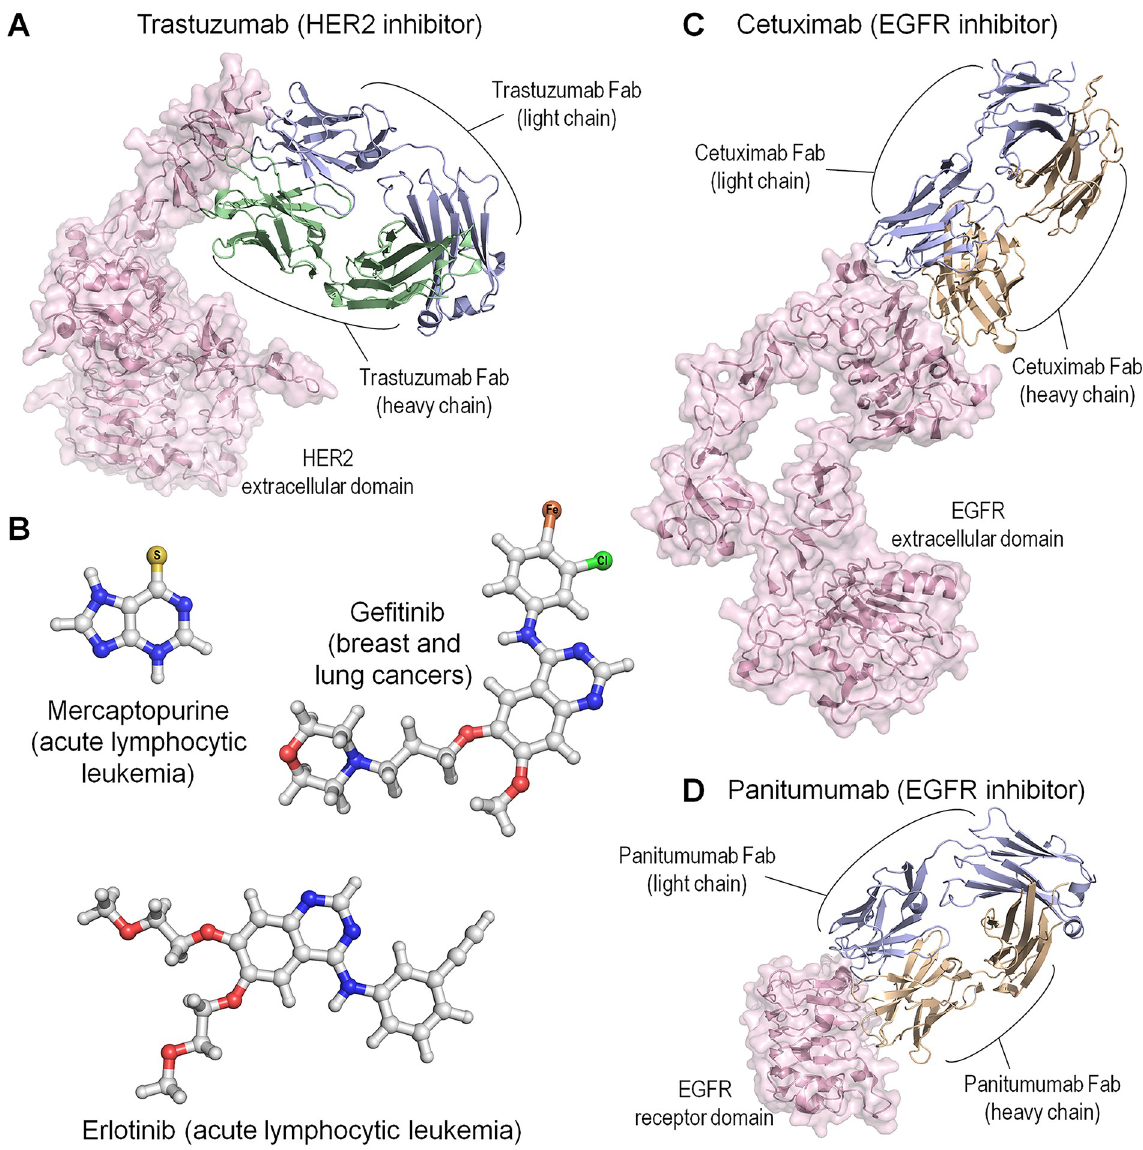
Fig 1. Examples of precision pharmacology. (A) Crystal structure of HER2 extracellular domain in complex with trastuzumab (Herceptin) Fab (PDB code: 1N8Z). Trastuzumab is a monoclonal antibody targeting HER2 receptor positive for metastatic breast cancer. (B) Molecular structures of mercaptopurine (Purinethol), gefitinib (Iressa), and erlotinib (Tarceva). Mercaptopurine is specifically used to treat acute lymphocytic leukemia. Gefitinib is an EGFR inhibitor used to treat breast, lung, and other cancers. Erlotinib is also an EGFR inhibitor used to treat NSCLC, pancreatic cancer, and several other types of cancer. In the structure, C, N, and O atoms are denoted as white, blue, and red spheres, respectively. Hydrogen atom is represented as an edge of stick. Other heavy atoms, S, Cl, and Fe atoms, are marked on the sphere. Molecular topologies with the coordinates are generated by using Avogadro software [412]. (C) Crystal structures of EGFR extracellular domain in complex with cetuximab (Erbitux) Fab (PDB code: 1YY9) and (D) EGFR receptor domain 3 in complex with panitumumab (Vecitibix) Fab (PDB code: 5SX4). Both cetuximab and panitumumab are monoclonal antibodies targeting EGFR. EGFR, epidermal growth factor receptor; Fab, antigen-binding fragment; HER2, human epidermal growth factor receptor 2; NSCLC, non-small cell lung cancer; PDB, protein data